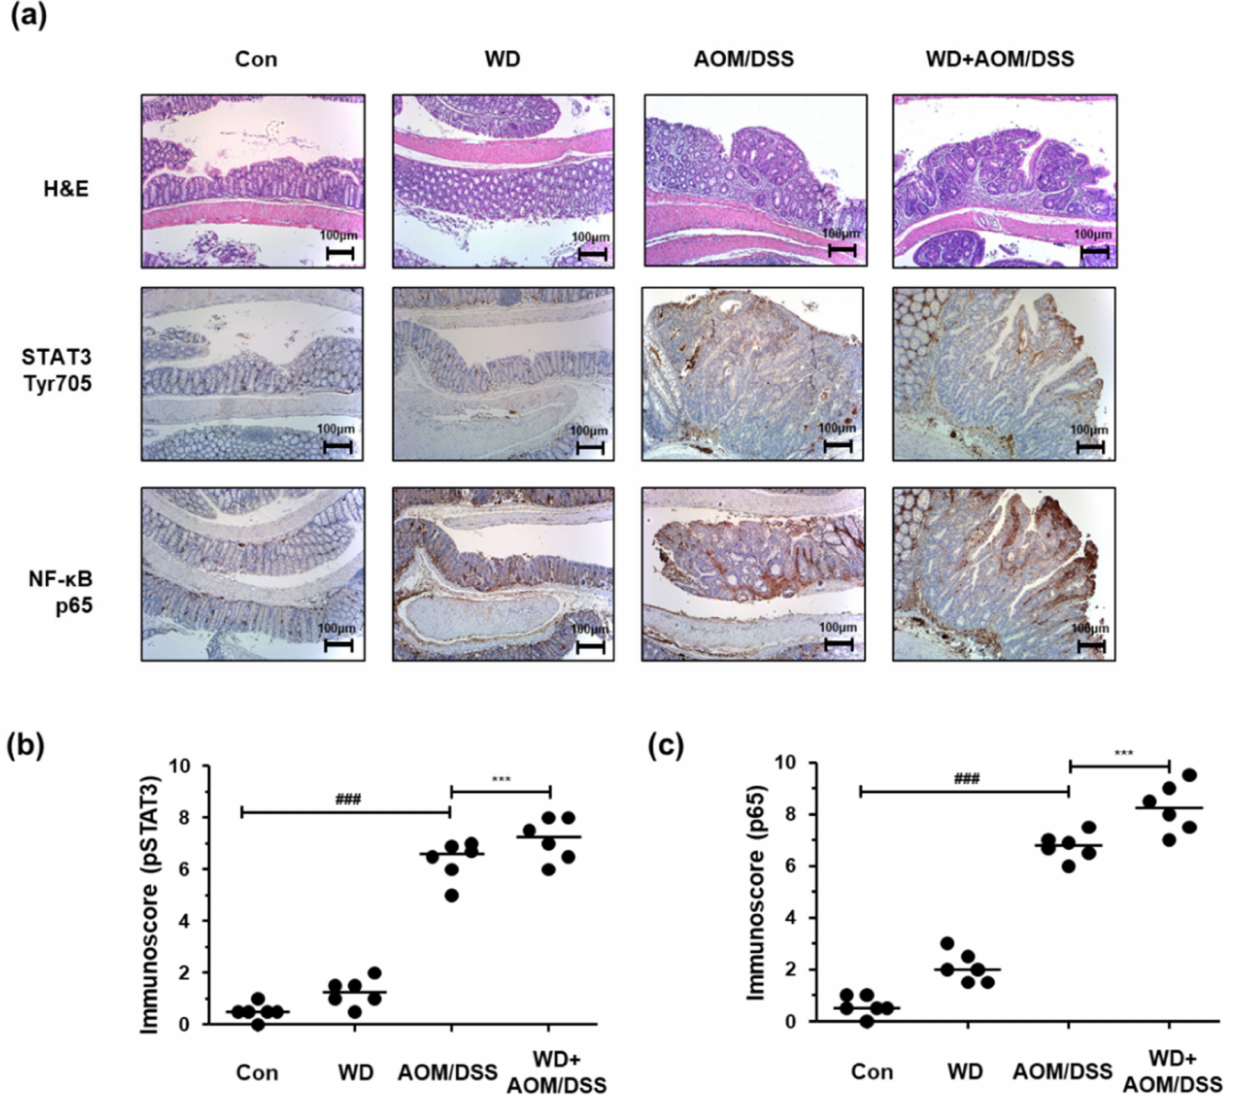
Figure 2. Effect of WD consumption on protein expression of NF- κ B and STAT3 in an AOM/DSS-induced CAC mouse model. ( a ) Colon tissue sections from each group stained by H&E and for NF- κ B p65 and STAT3 Tyr705 (original magnification, 100 × ); ( b ) immunoscores for STAT3 Tyr705; ( c ) immunoscores for NF- κ B p65. The values are the means ± SD ( n = 6); ### p < 0.001 when compared to Con; *** p < 0.001 when compared to